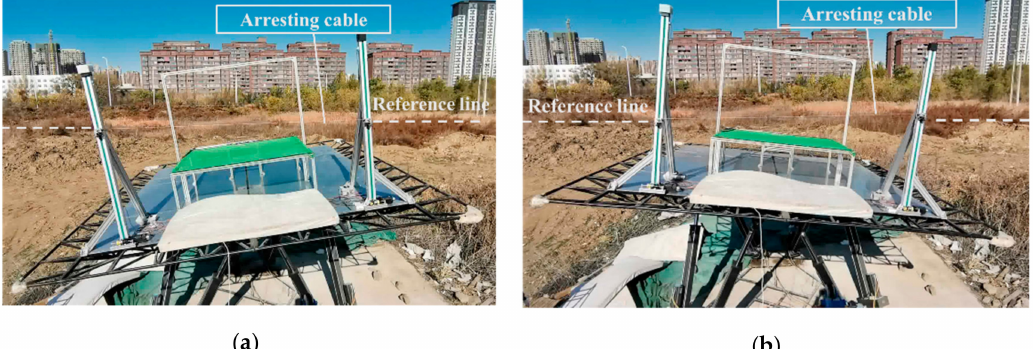
Figure 15. Attitude maintenance of the arresting cable in two typical USV attitude situations in wave compensation dynamic test. ( a ) The attitude of the arresting cable when the USV is tilted to the left and rear. ( b ) The attitude of the arresting cable when the USV is tilted forward to the right.